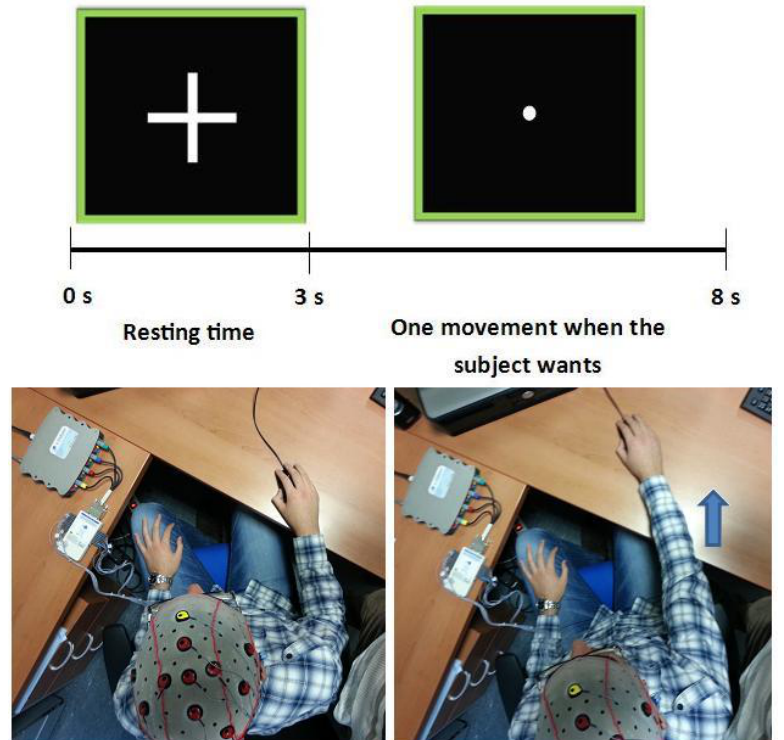
Figure 3. Description of the experiment. Resting position ( bottom left ) and final position of the movement ( bottom right